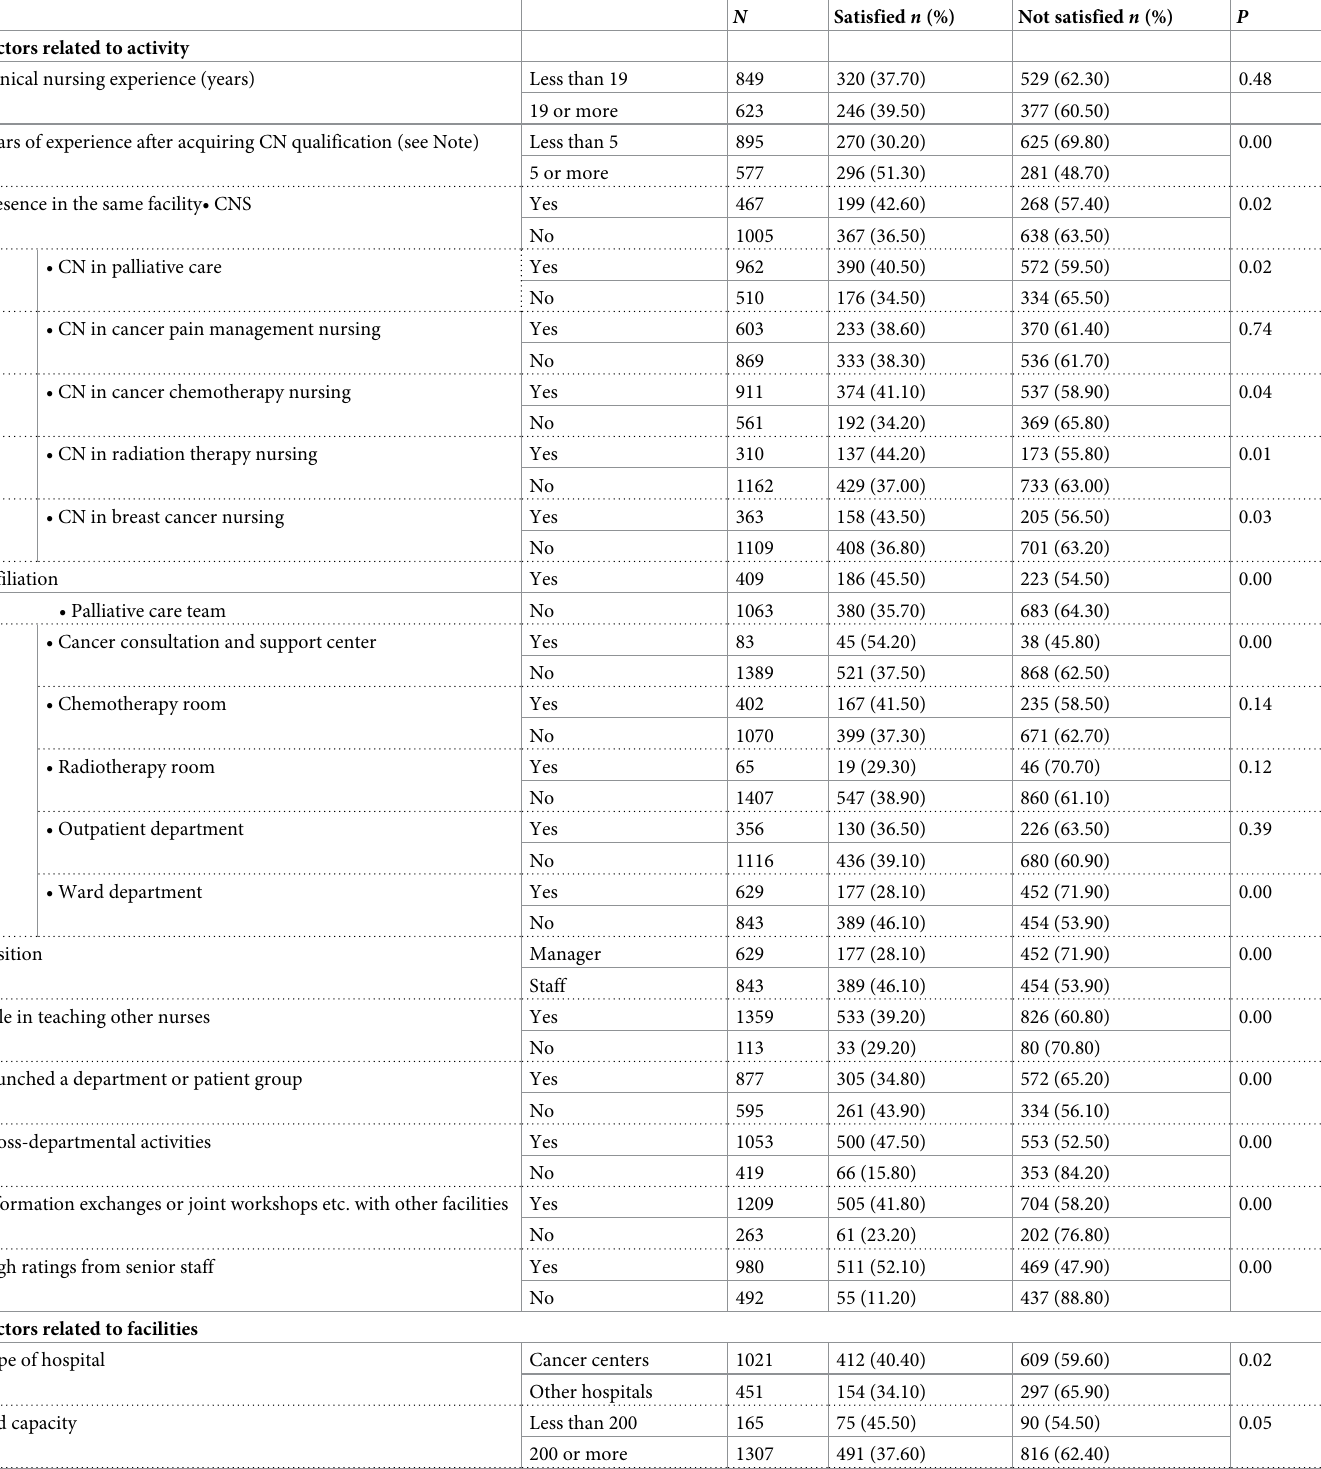
Table 4. Univariate analyses for